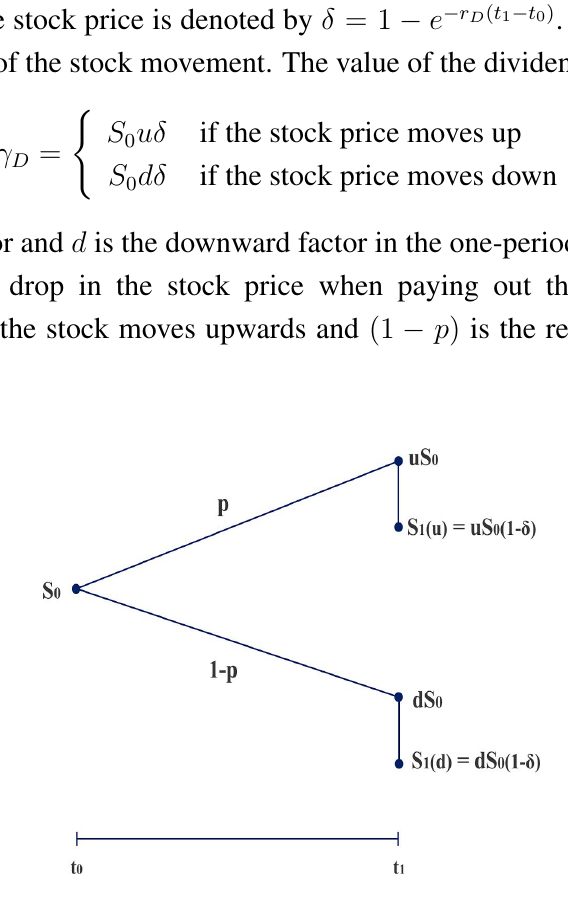
Figure 2. One-period binomial asset pricing model with a discrete